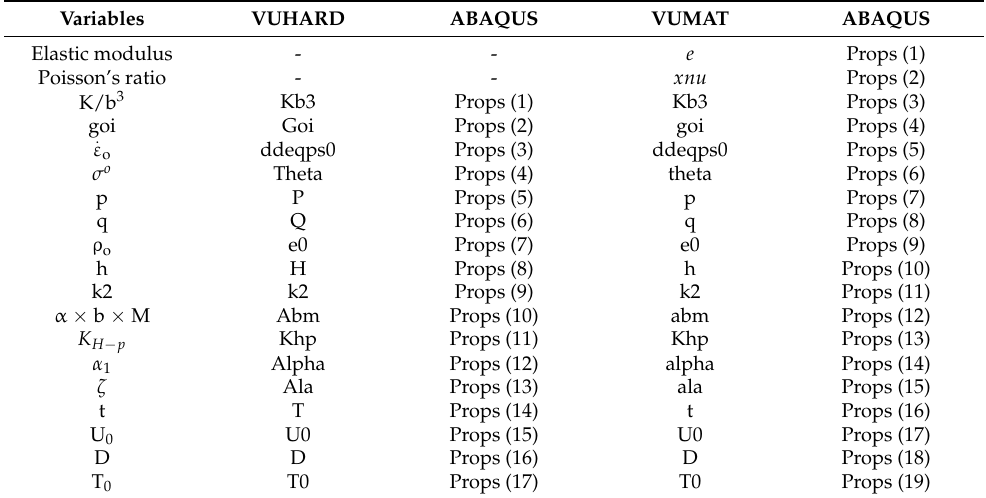
Table 3. The VUHARD and VUMAT subroutine and the ABAQUS material property definitions.